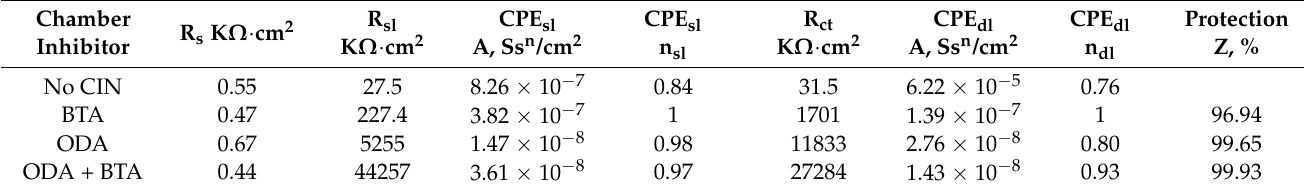
Table 13. Protective effects of the CINs by the blocking and activation mechanisms after brass cham- ber treatment in different modes. T CT = 120 °C, and τ CT = 60 min.